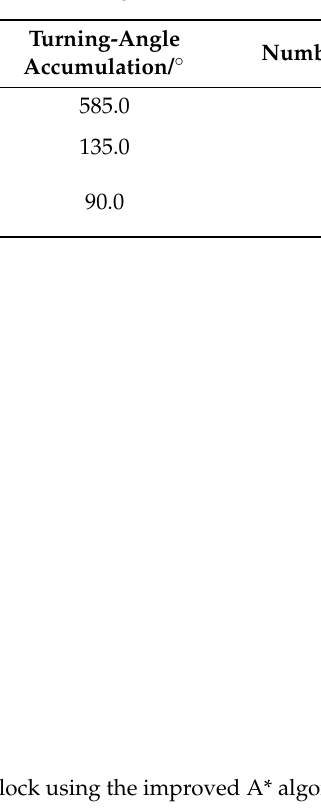
Figure 9. Generated path of the A* algorithm and improved A* algorithm: ( a ) A* algorithm. ( b ) Improved A* algorithm with C a = π /4. ( c ) Improved A* algorithm with C a = π /8. Table 2. Simulation results of A* algorithm and improved A* algorithm.